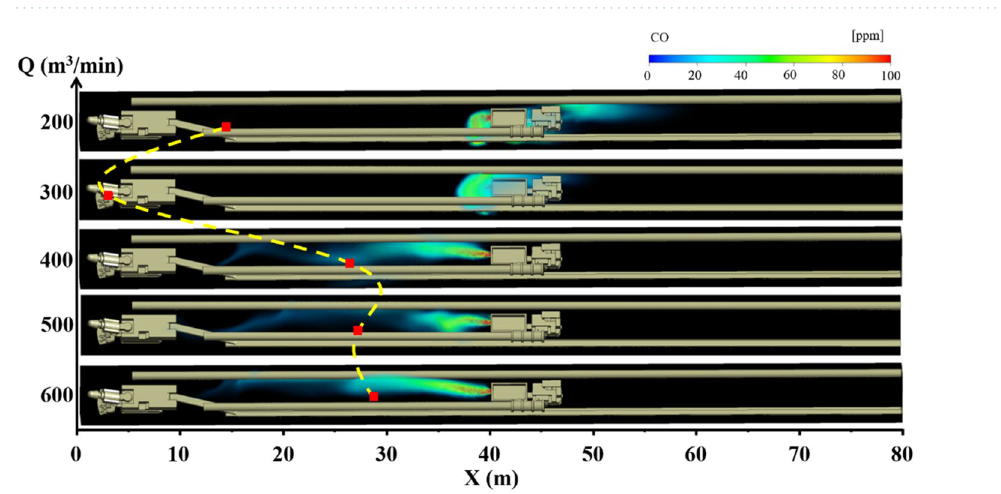
Figure 5. CO gas distribution under different air volumes Q when L = 40